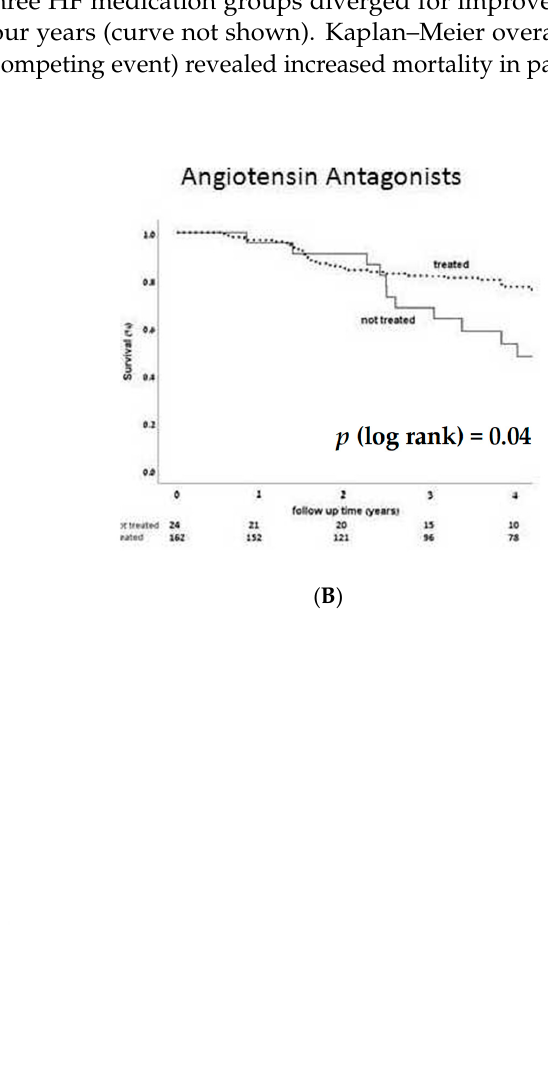
Table 5. Cox proportional-hazards multivariate model for overall mortality.